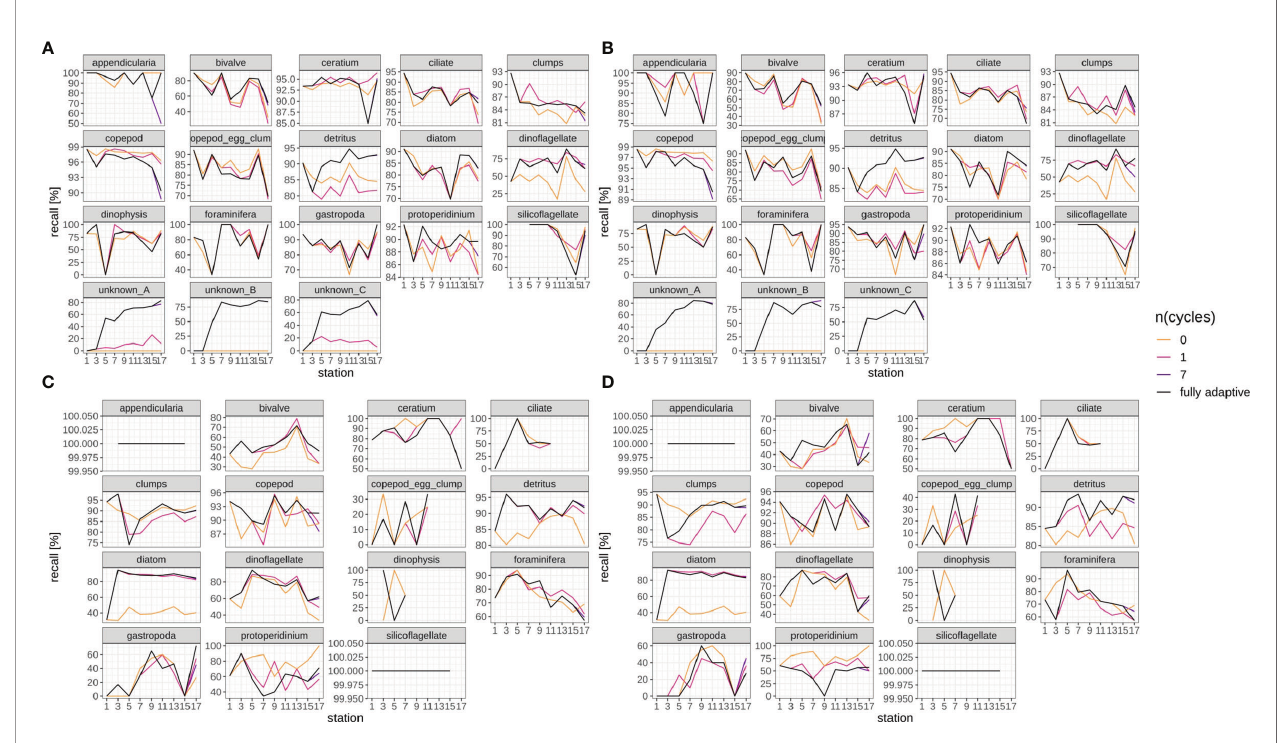
FIGURE 6 | Class-speci fi c recall trajectories. Black line represents fully adaptive DOC implementation (training-set update every second station); colored lines represent less-adaptive implementations (denoted by the number of adaptation cycles). (A) : September survey, fi rst replicate, (B) September survey, second replicate; (C) : December survey, fi rst replicate, (D) : December survey, second replicate. Replicates differ in the random selection of images for training-set updates and random parameter initializations of models before training (see Case Studies – North Sea Surveys ). Trajectories for all nine adaptation modes are shown in Figure SI XI/2